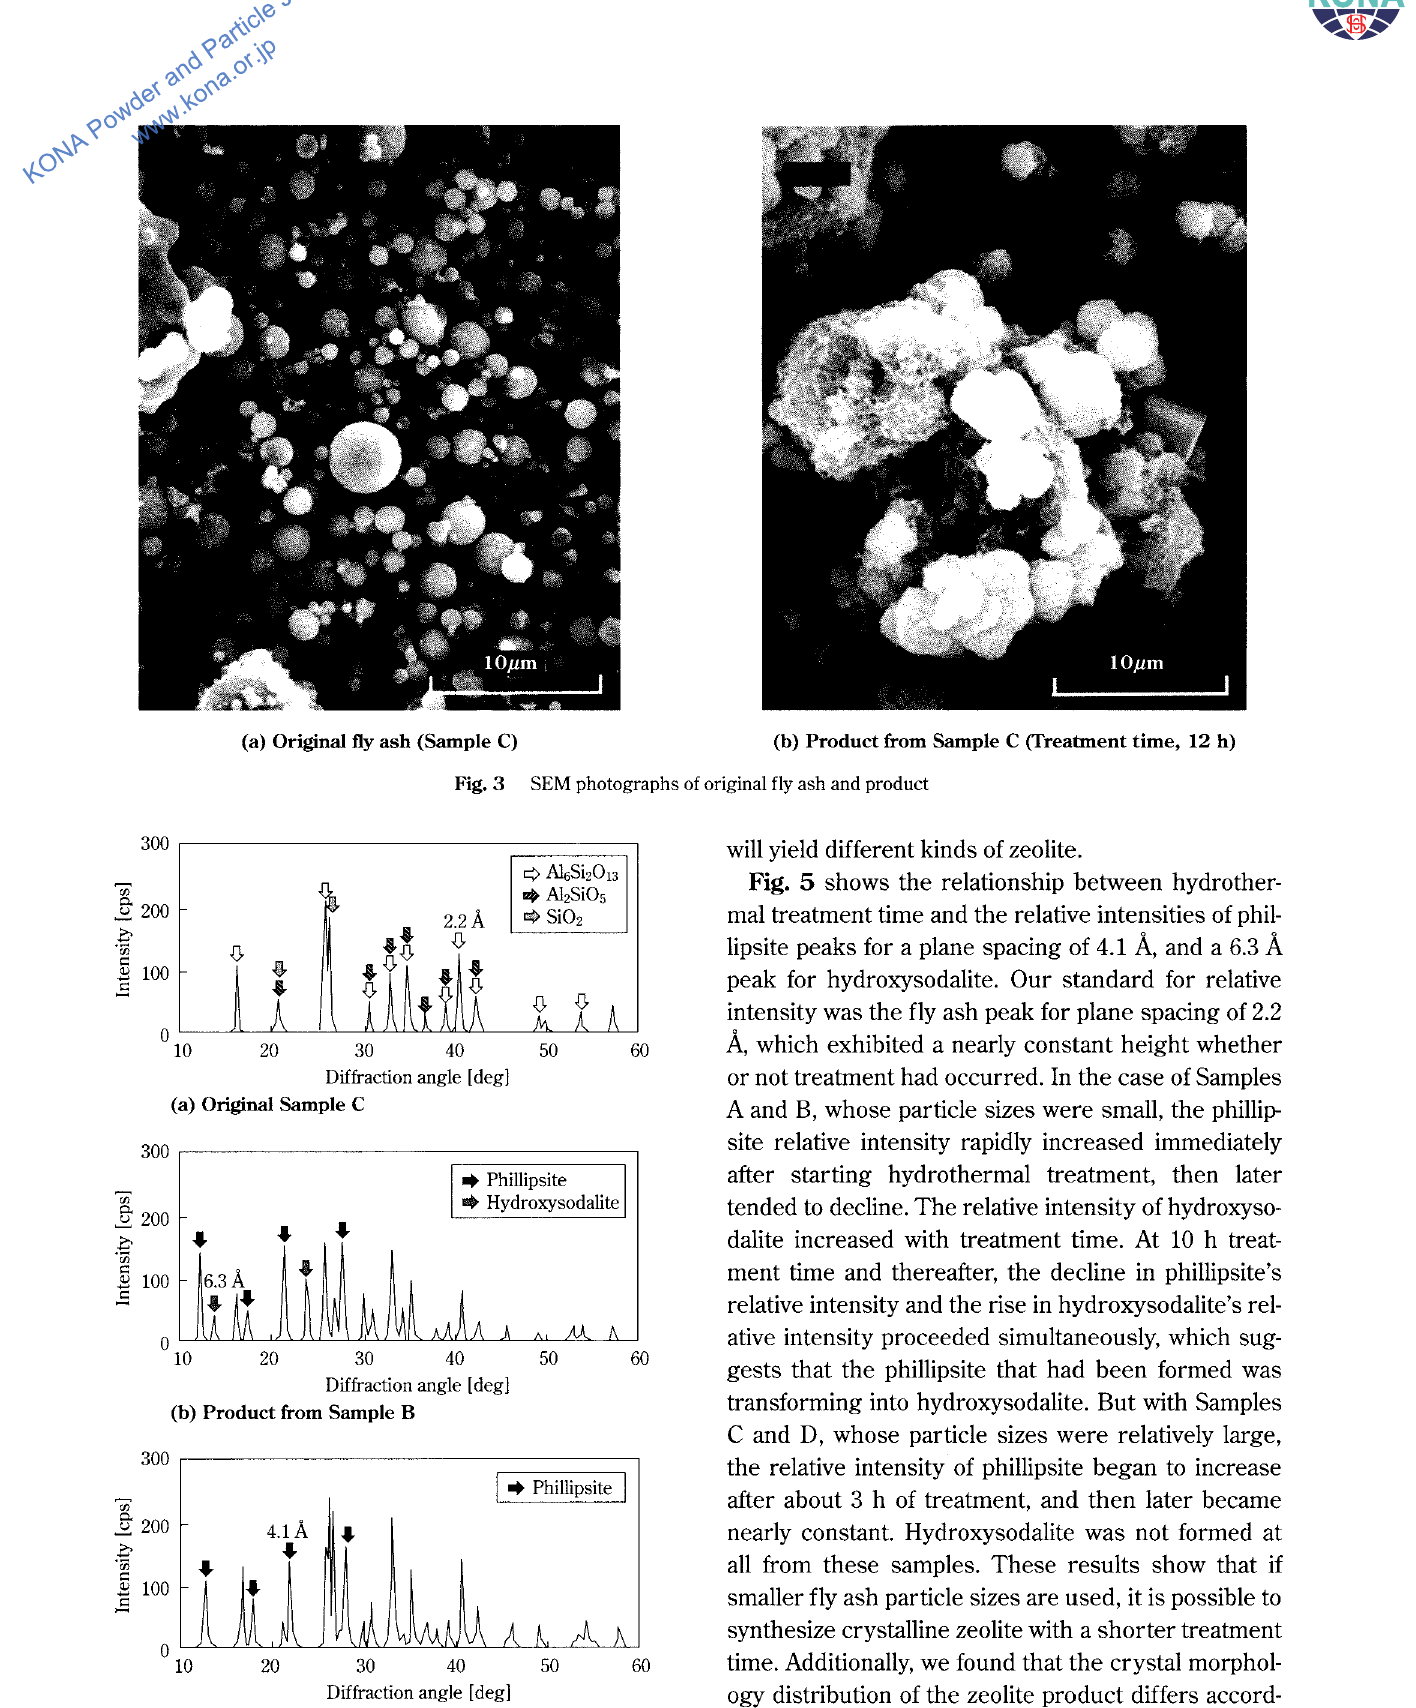
XRD peak charts for original fly ash and products